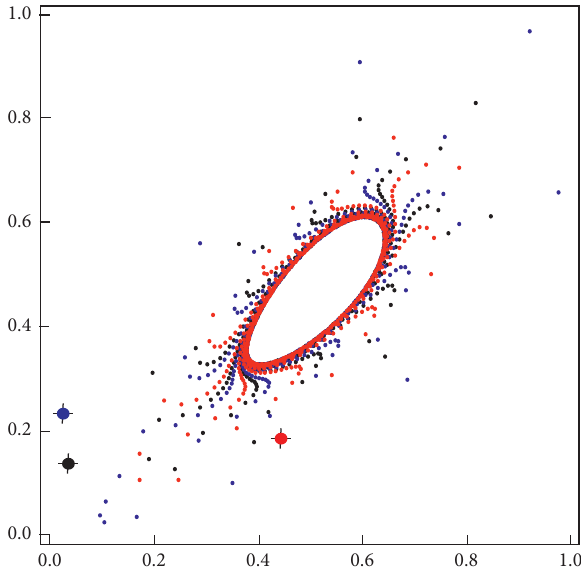
Figure 2: Trajectory of some solutions of equation (1) for parameters a � 0 . 49 and f � 0 . 125. Picture is produced by Dynamica 5.